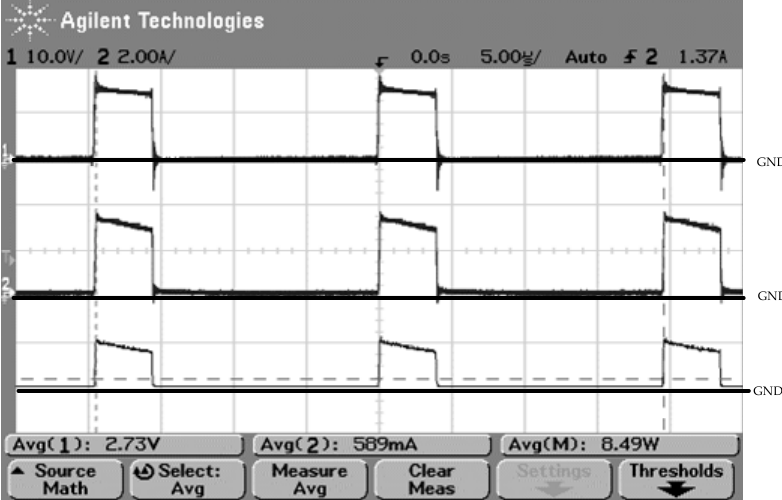
Figure 18. Output characteristics of proposed boost converter with f s = 50 kHz. ( Top Trace ) Output Voltage (10 V); ( Middle Trace ) Output Current (2 A/div); ( Bottom Trace ) Output Power (20 W/div).